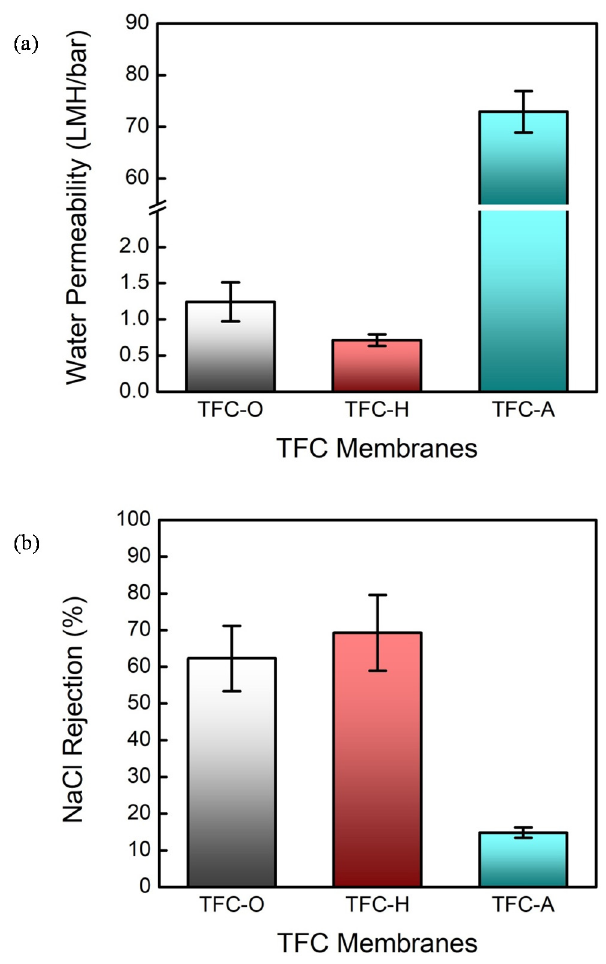
Figure 5. Evaluating the TFC membranes with the original PAN substrate and the PAN substrates with the heat treatment and alkaline treatment in terms of ( a ) their water permeabilities and ( b ) their rejections of sodium chloride. The flux–pressure relationship was determined with a hydraulic pressure of 5 bar; the salt rejection was measured using an aqueous feed solution of 20 mM NaCl; the error bars correspond to the standard deviations of the three independent measurements.